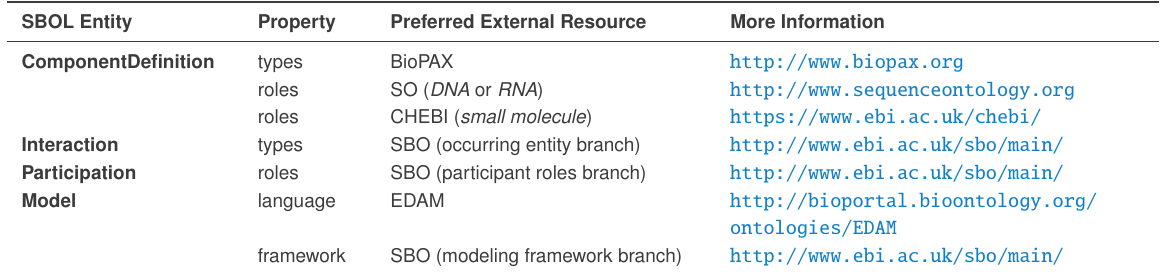
Table 13: Preferred external resources from which to draw values for various SBOL